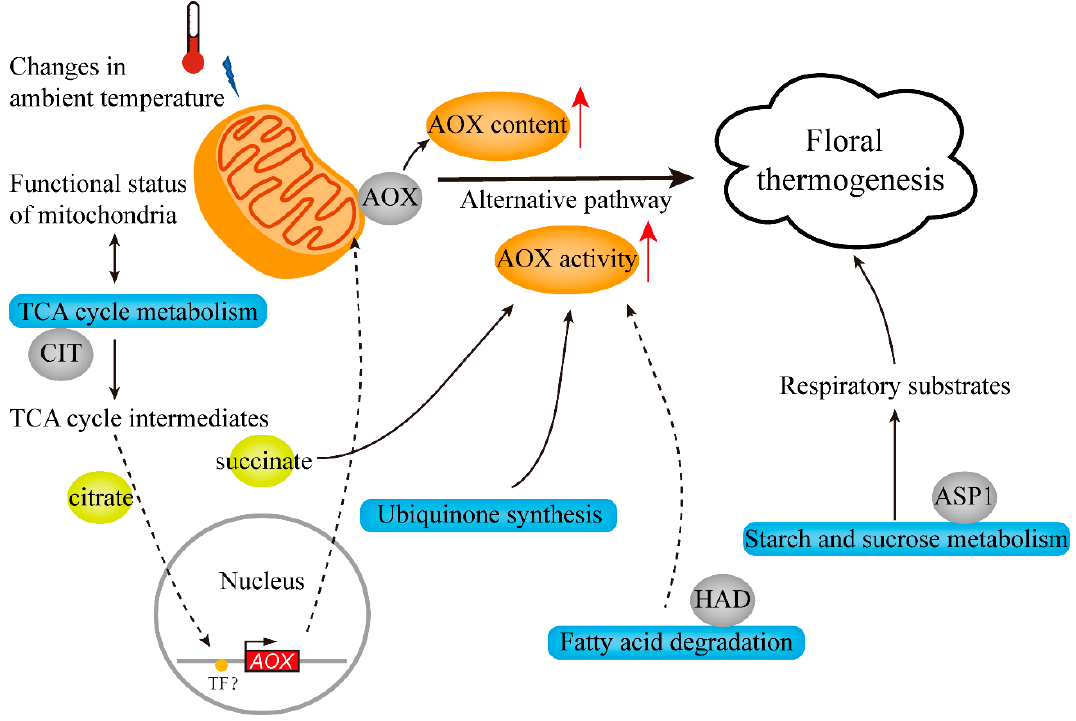
Figure 8. Putative model for the regulatory networks involved in the regulation mechanism of floral thermogenesis in N. nucifera . TCA, tricarboxylic acid; CIT, citrate synthase; HAD, 3-hydroxyacyl-CoA dehydrogenase; ASP1, glucose-1-phosphate adenylyltransferase small subunit.